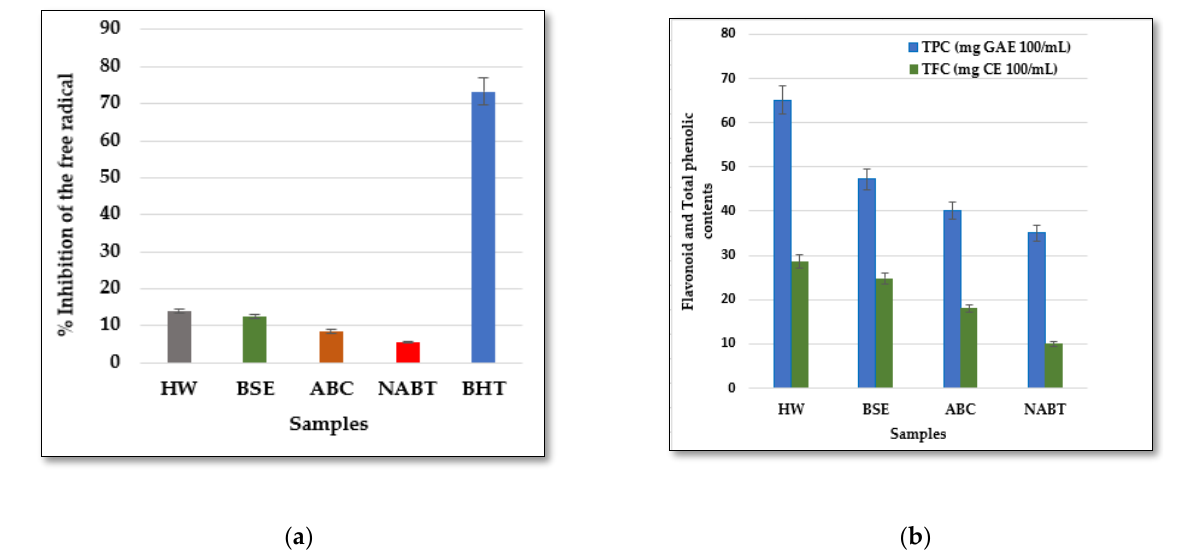
Figure 4. Total flavonoid, phenolic contents ( a ), and percentage inhibition of free radical scavenging activity ( b ) of the analyzed samples. HW : Hopped Wort; BSE : Barley Seed Extract; ABC: Alcoholic Beer using Classical fermentation; BHT: Butylated hydroxytoluene; NABT : Non-Alcoholic Beer using Thermal process.